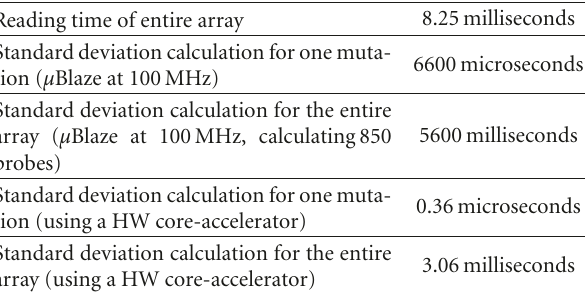
Table 1: Implementation results: calculation of standard deviation for the sensor data with and without hardware